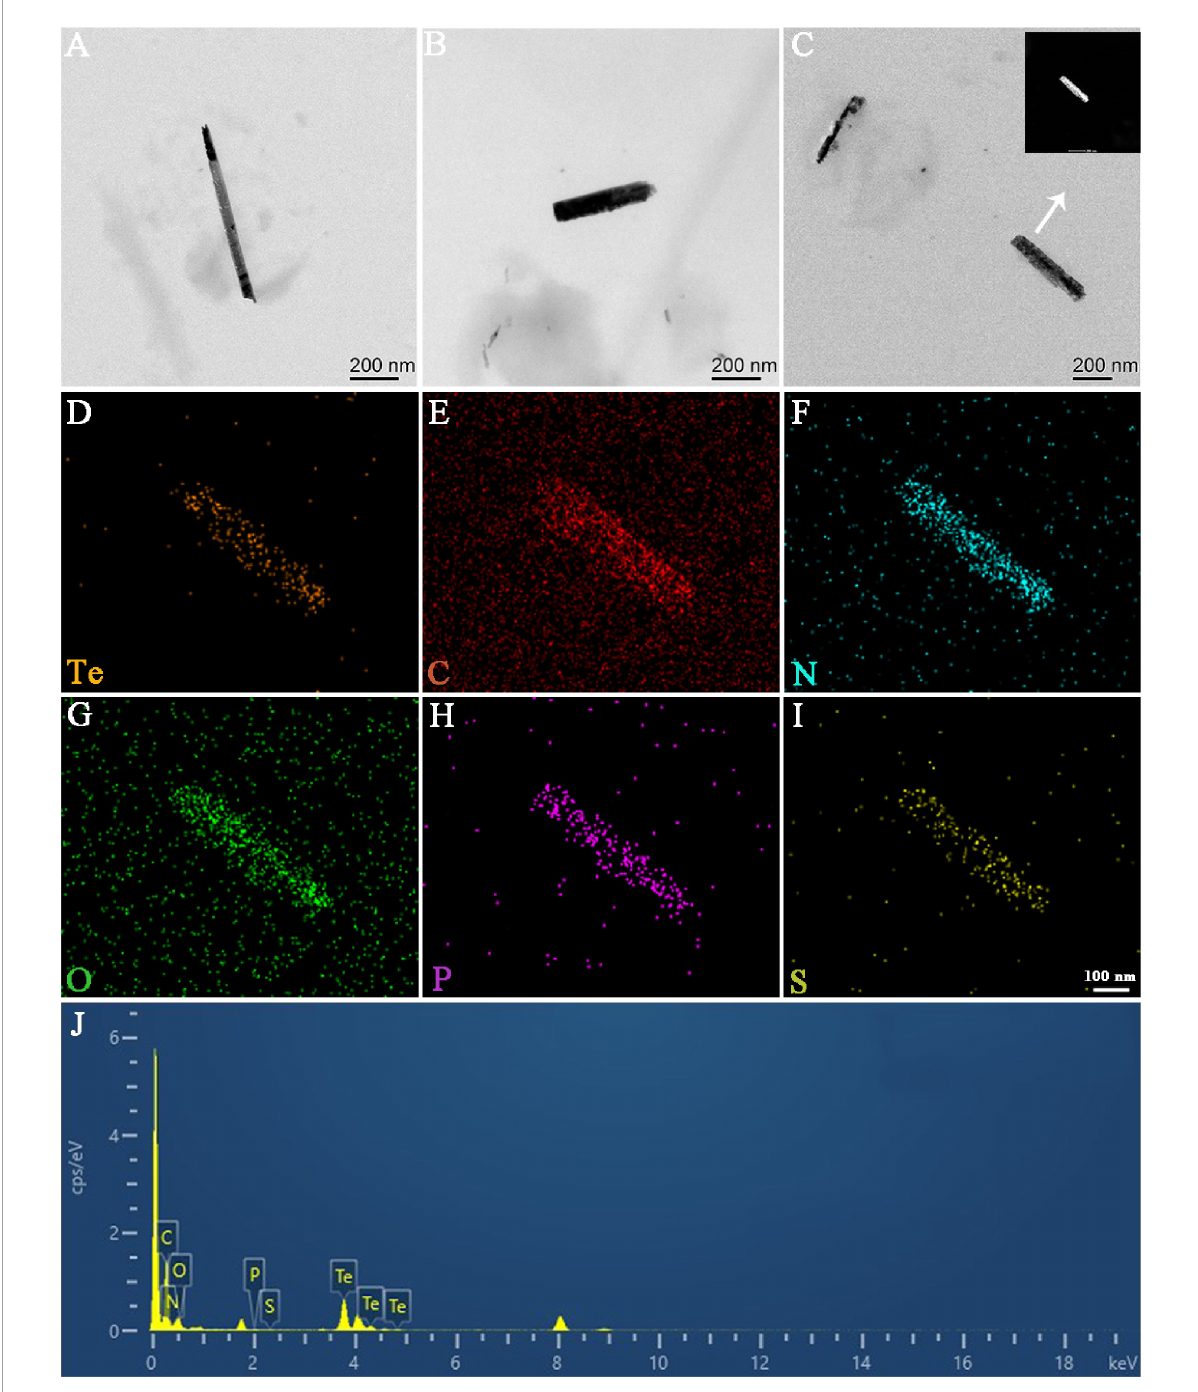
FIGURE4 TEM-element mapping analysis of Bio-TeNPs. The morphology of Bio-TeNPs (A–C) . The Te (D) , C (E) , N (F) , O (G) , P (H) , and S (I) in Bio-TeNPs were analyzed by element mapping. The relative contents of each element were analyzed by EDS (J) .